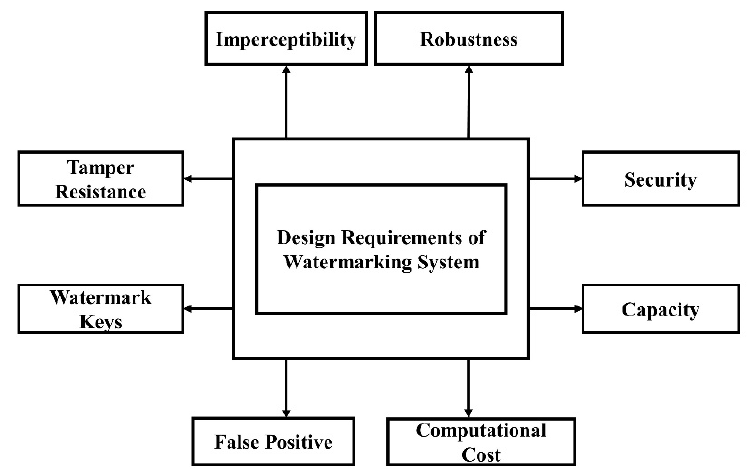
Figure 2. Design requirements for an image watermarking system.